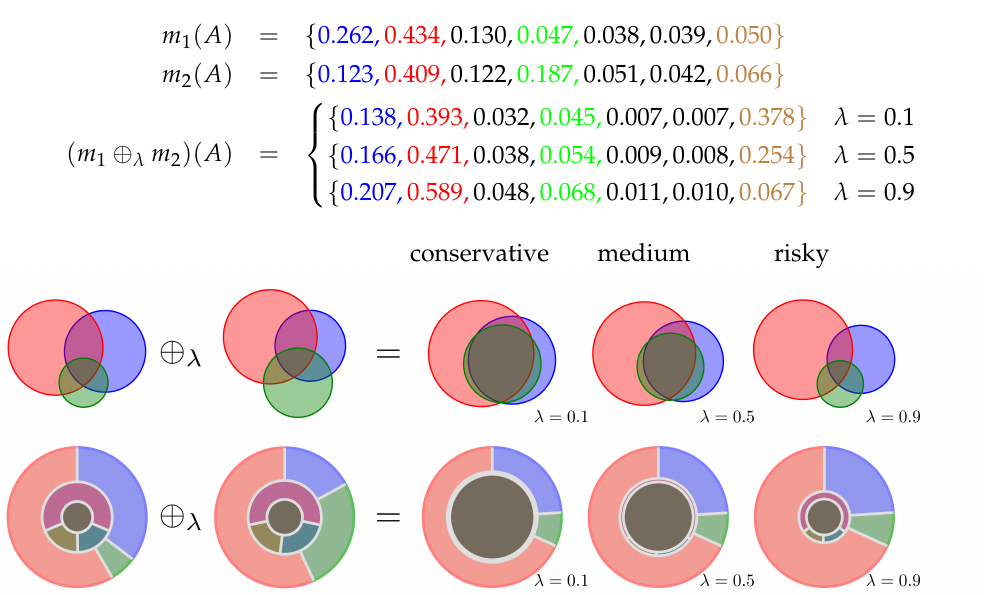
Figure A1. Adding two rather consistent pieces of evidence with Formula (4). A larger value of λ (less conservative) seems to be preferable. Masses for ambiguous outcomes such as { R , B } almost vanish. The first and the second rows show different graphical representations of the same